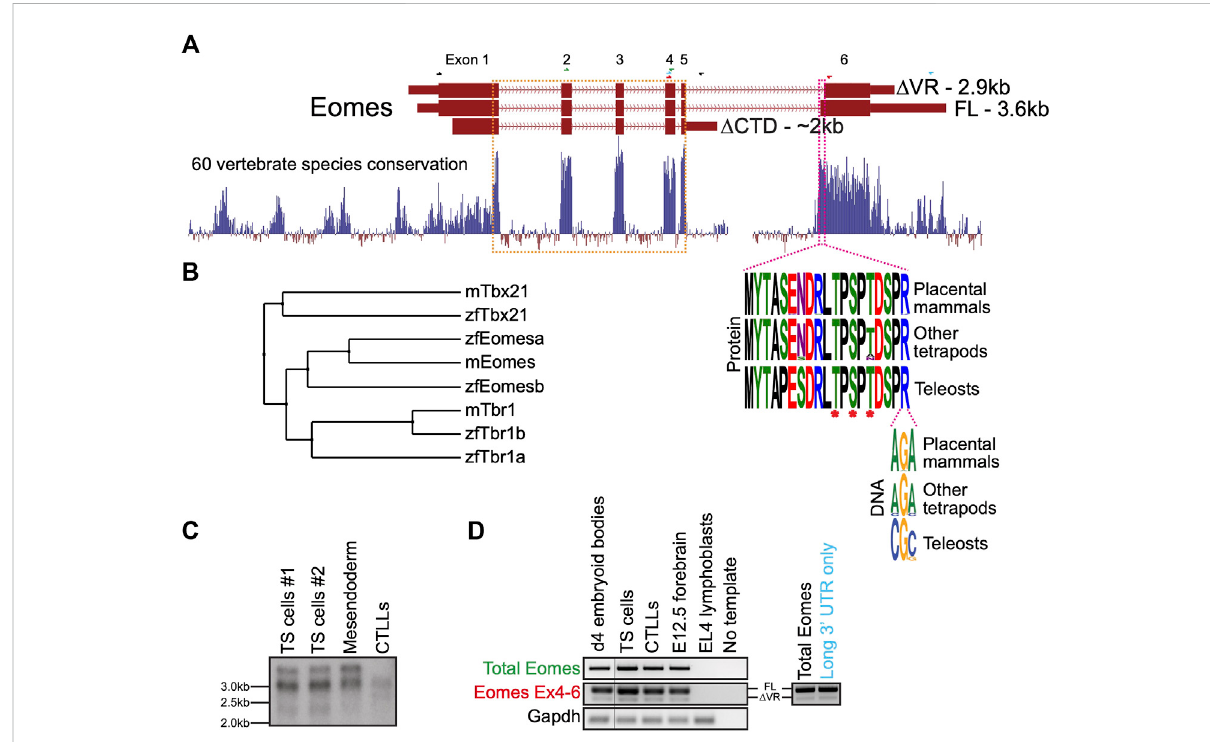
FIGURE 1 Mouse Eomes has multiple isoforms, including a mammalian-speci fi c alternative splicing event. (A) Gene model with conservation track and sequence logos for variant region. All transcripts are Ensembl version 107 annotations - Δ VR transcript is ENSMUST00000111763; FL transcript is ENSMUST00000035020; Δ CTDtranscriptisENSMUST00000150633.Annotatedtranscriptsizesareindicated,aswellasaminoacidconservationof theVR betweenplacental mammals, other tetrapods and teleosts, andthe variation within theterminal VR arginine codon.The VR isde fi ned by the amino acids present in ENSMUSP00000035020 (encoded by ENSMUST00000035020) that are absent from ENSMUSP00000107393 (encoded by ENSMUST00000111763). The T-box is outlined in orange and the VR in pink. Asterisks indicate known phosphorylated amino acid residues. RT- PCR primer pairs are indicated as half arrows and colour-coded as follows: black – to establish connectivity between the annotated start codon and Δ CTD isoform 3 ′ UTR; green – toassess totalEomesthroughampli fi cationofexon 2 – 4;blue – to amplify EomescDNA between exon 4andthedistal 3 ′ UTR; red – to assess alternate splicing at exon 6. (B) BLOSUM62 average distance evolutionary tree of the Tbr1 subfamily showing relationships between mouse and zebra fi sh genes. (C) Northern blot showing Eomes transcripts in different cell types using a probe against the T-box. Data for two independent trophoblast stem (TS) cell lines are shown. Mesendoderm is P19Cl6 cells after 4 days of DMSO induced differentiation. CTLLs are IL-2-dependent T-cell lymphocytes derived from ATCC TIB-214. (D) RT-PCR showing relative levels of FL and Δ VR isoforms (left), and nested PCR showing FL/ Δ VR ratio for long 3 ′ UTR transcripts (right). Day 4 differentiated embryoid bodies contain cells mimicking embryonic endoderm. CTLLs are IL-2-dependent T-cell lymphocytes derived from ATCC TIB-214. EL4 cells are a negative control for Eomes expression. Gapdh is a loading control. Locations of primer pairs used for RT-PCR are shown in panel A and the text colour-coded accordingly. Nested PCR to analyse exon 6 splicing in transcripts containing the long 3 ′ UTR was performed using the blue primer pair in panel A, followed by the red primer